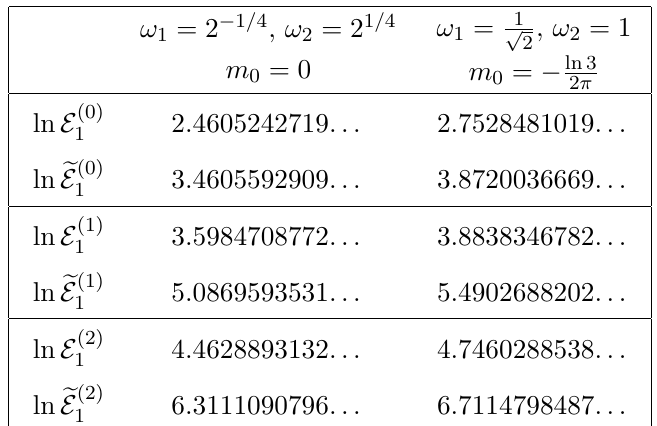
Table 3. Numerical eigenvalues E ( n )